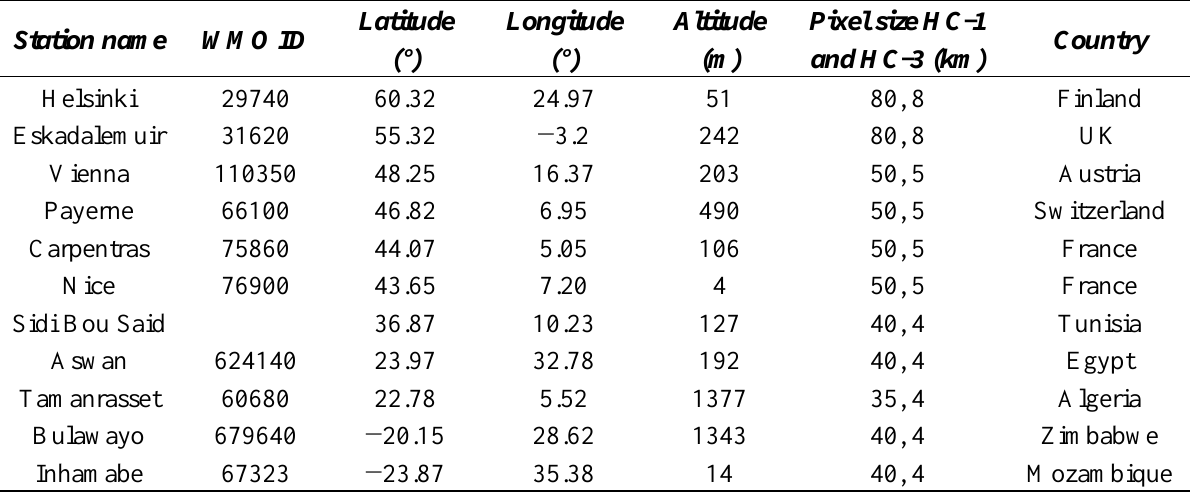
Table 3. Ground-measuring stations used for